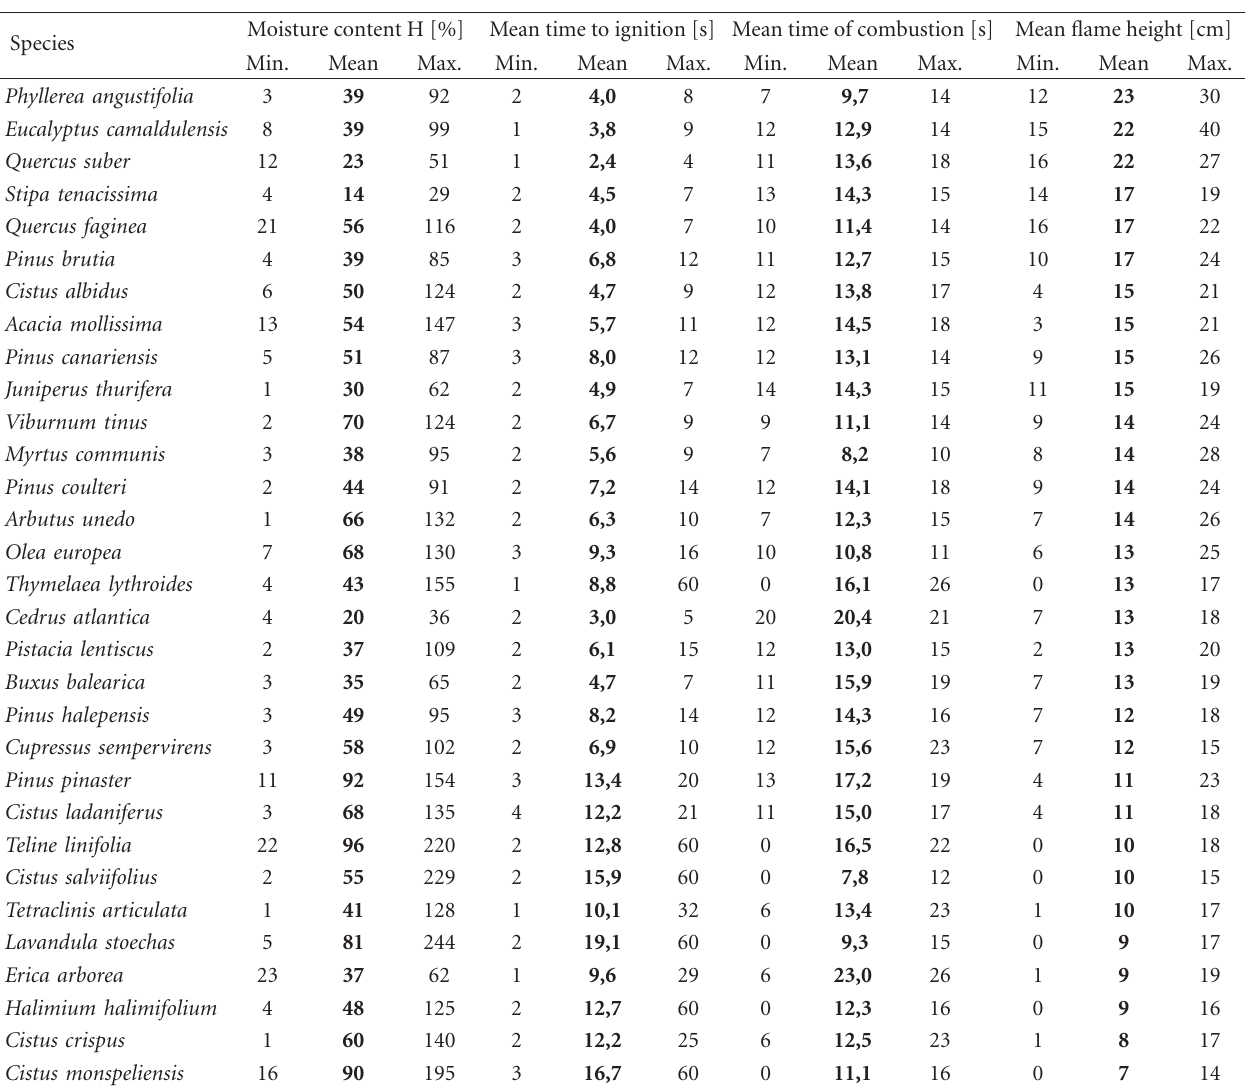
Table 4: Mean values of the moisture content and the flammability test parameters observed for the forest fuel samples collected from di ff erent Moroccan forest species (species are sorted in a mean flame height decreasing